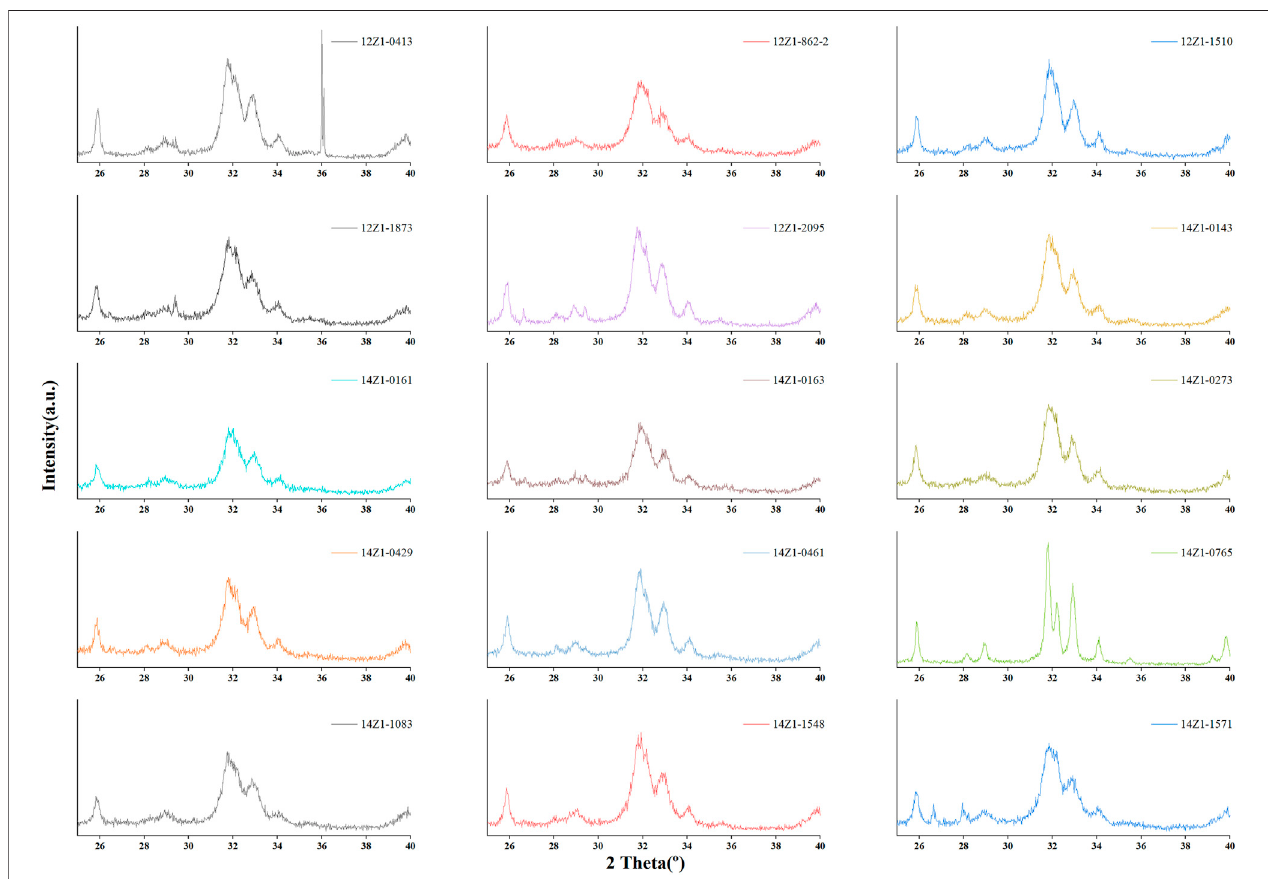
FIGURE 6 | XRD pattern of fossil bone with a higher crystallinity ( > 0.3) of hydroxyapatite.